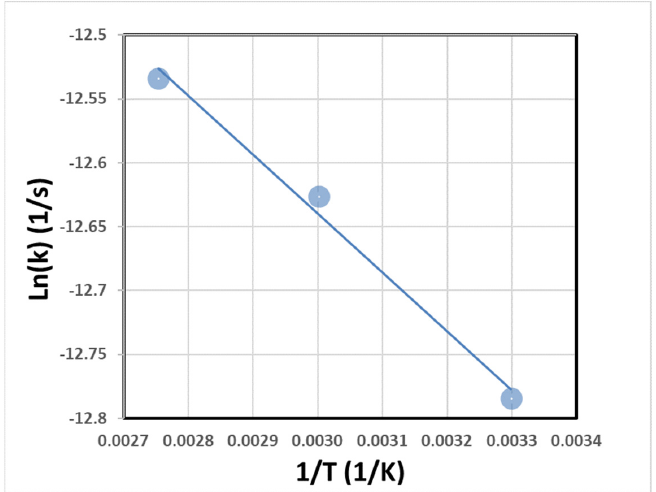
Table 6. The R-square and reaction constant values are generated by fitting the degree of reaction with the kinetic reaction models. Figure 8. The temperature dependence of reaction kinetic constant from the third-order kinetic